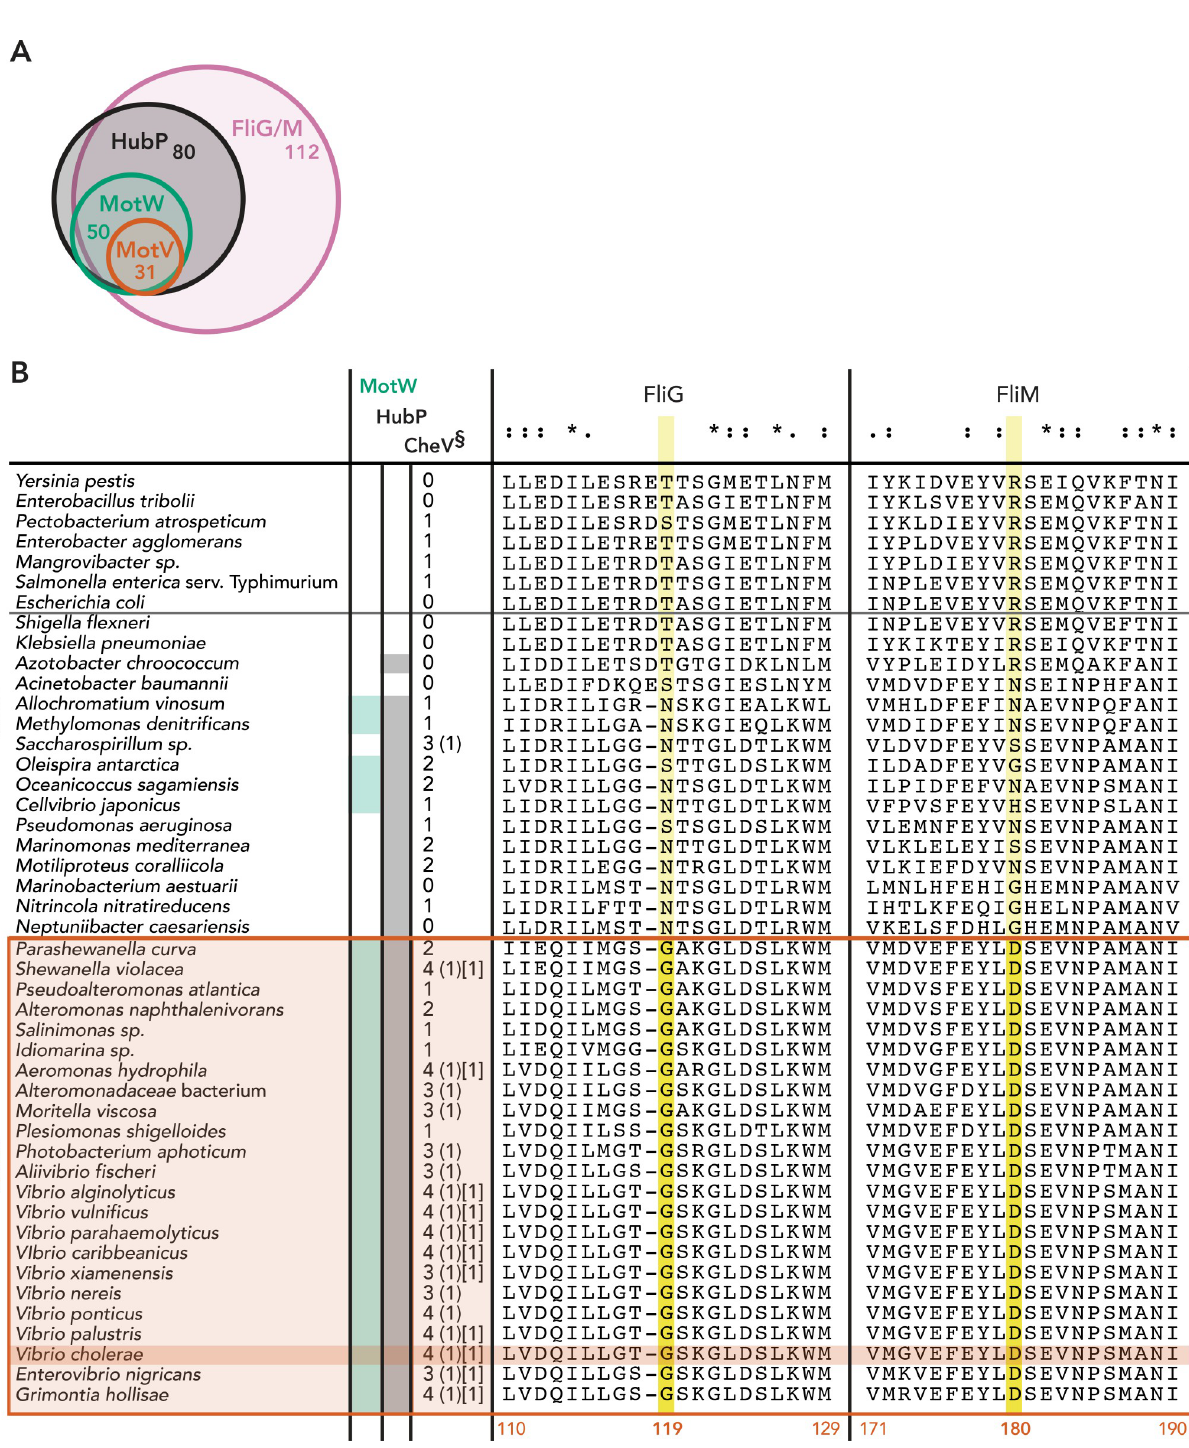
Fig 4. Multiple sequence alignments of FliG and FliM. (A) Presence of C-ring (FliG/M), HubP, MotV and MotW in 132 γ -proteobacteria species shown in Venn diagram. (B) Alignments of FliG and FliM from different γ -proteobacterial species. For each organism, presence of HubP, MotW and CheV homologs are indicated. (§) In addition to total number of CheV proteins, number of CheV variants with non-canonical ‘switch’ residues are indicated in round (A substitution) and square [T substitution] brackets (see text and Fig 5). Asterisk ( � ), colon (:), and period (.) indicate amino acids with full conservation, strongly similar properties, and weakly similar properties, respectively. Key residues differentially conserved in MotV + versus MotV - bacteria are labeled in yellow.